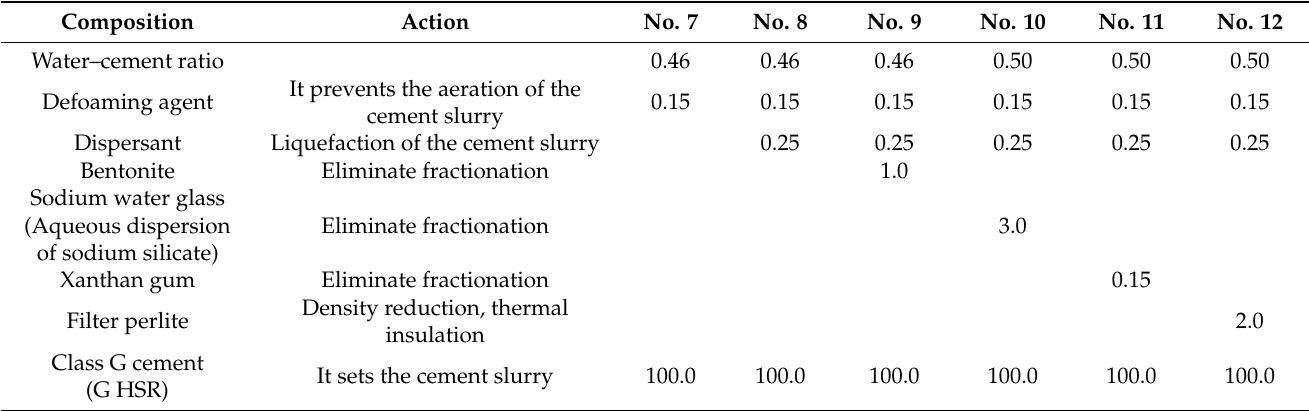
Table 2. Compositions of cement slurries based on class G cement.